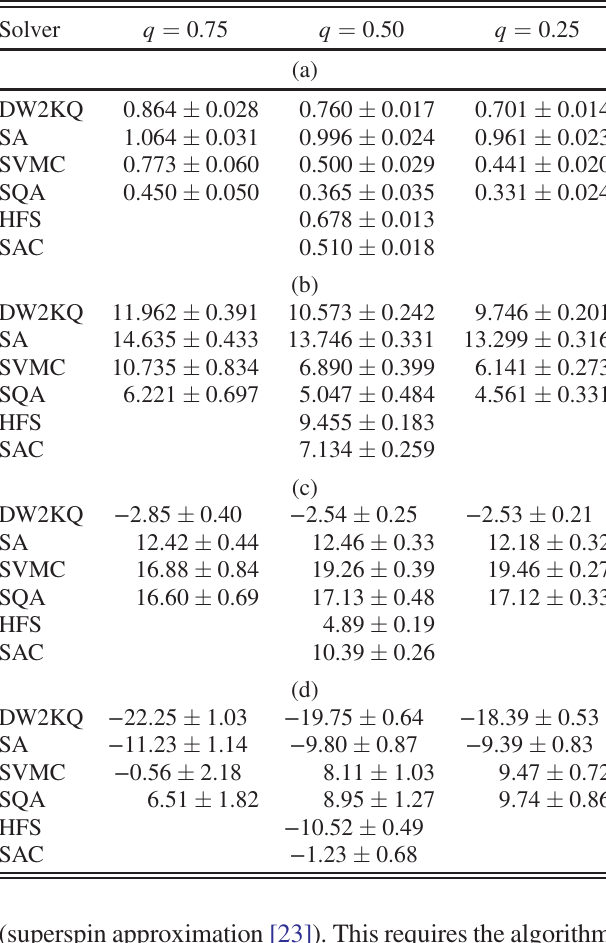
TABLE III. The coefficient b in fits to (a) exp ð a þ bL Þ and (d) exp ð a Þ L b for the logical-planted instances using L ∈ ½ 12 ; 16 (cid:2) . q denotes the quantile. Errors are 95% confidence intervals. Given here are the fits for SVMC and SQA at β ¼ 2 . 5